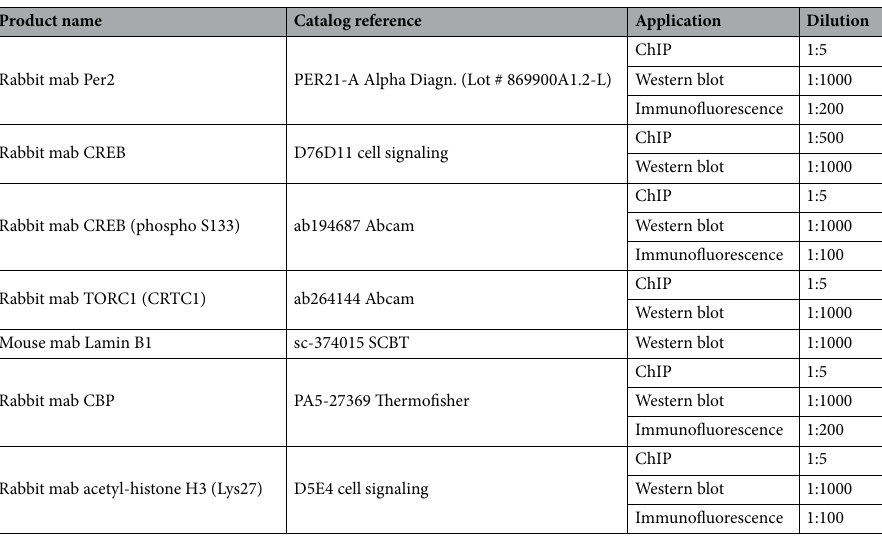
Table 2. List of antibodies used in the paper and relative